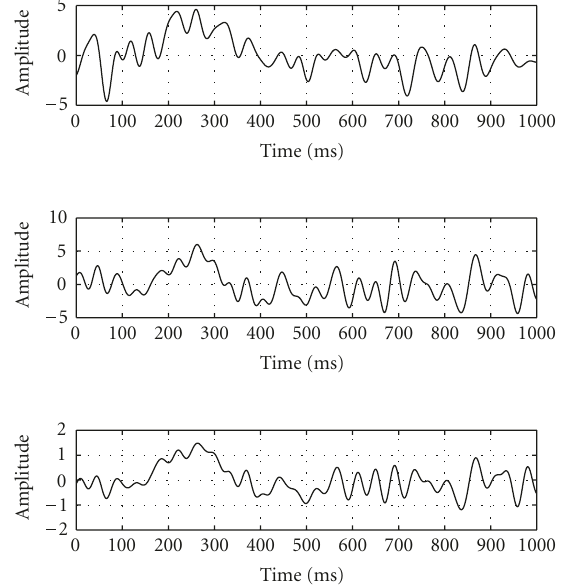
Figure 14: The top figure shows the output obtained by normal Infomax while the middle figure shows the CBSS output and the bottom figure shows the reference signal for a control subject.